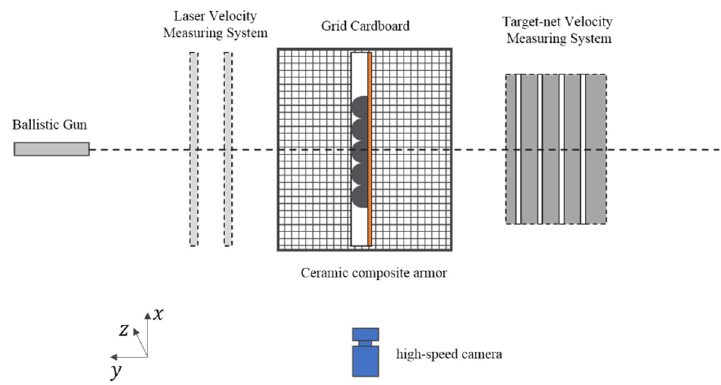
Figure 2. Experiment setup.